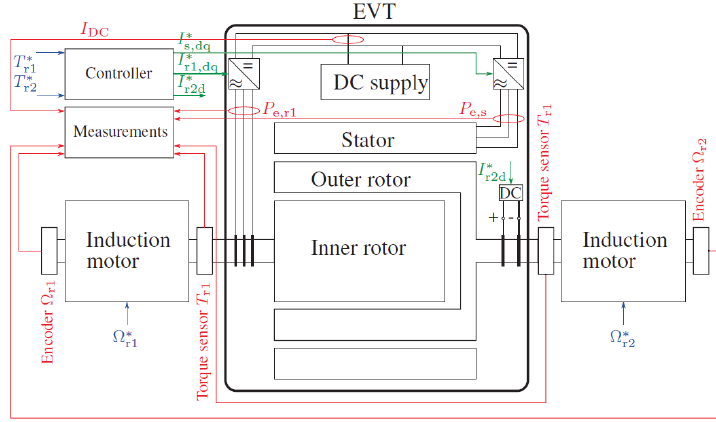
Figure 12. Schematic of the experimental setup [61] .